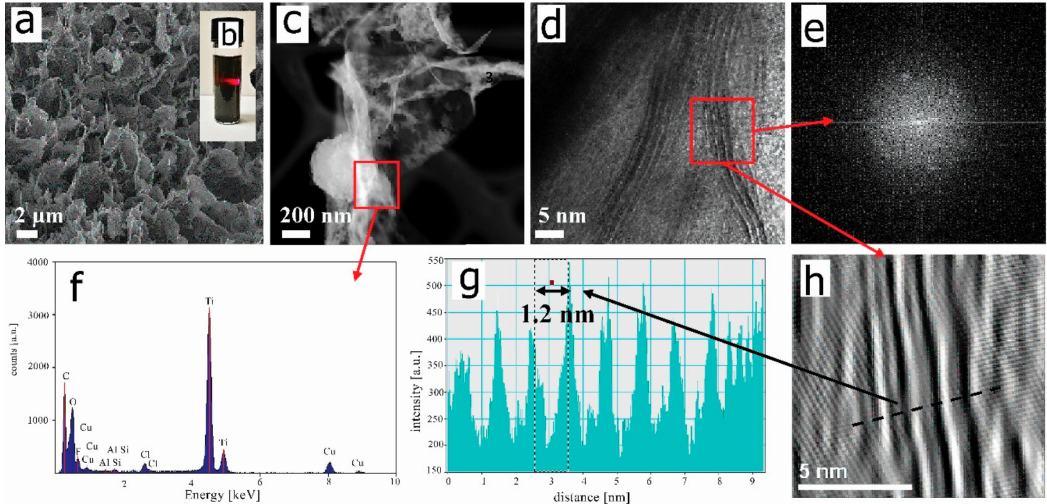
Figure 2. ( a ) SEM image of 2D Ti 3 C 2 T x MXene flakes after freeze-drying. ( b ) Tyndall e ff ect tested for redispersed nanocolloid. ( c ) STEM-HAADF and ( d ) HREM images of a single 2D flake after redispersion together with the corresponding ( e ) FFT image. ( f ) Results of the elemental EDS analysis. ( g ) Cross-sectional band intensity pattern. ( h ) IFFT image of the flake